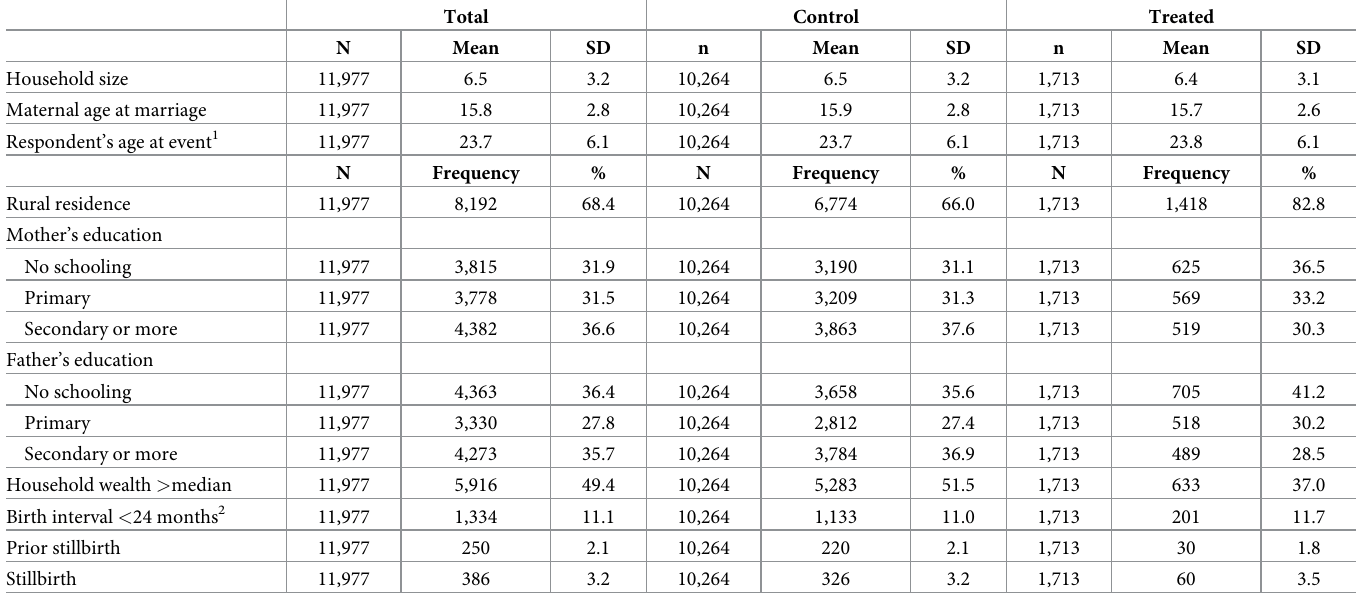
Table 3. Sample characteristics for analyses of pregnancies lasting at least 7 months from the period prior to the introduction of the MHVS in treated upazilas (before December 2006); BDHS